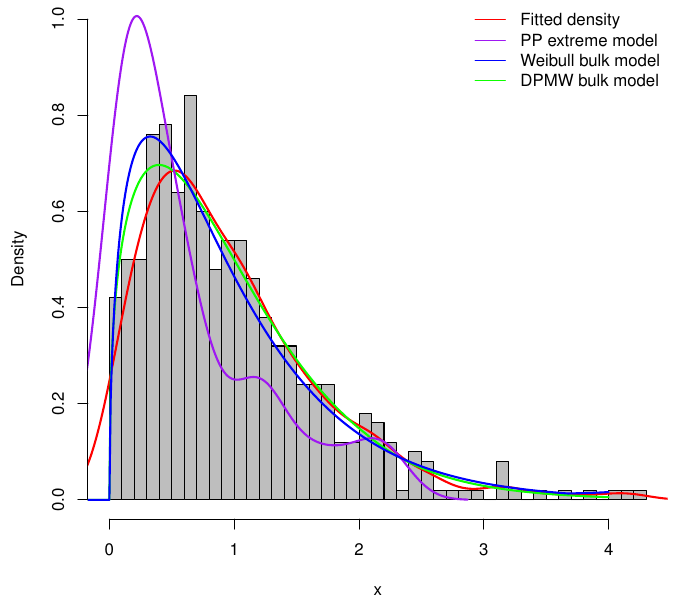
Figure 7. The posterior density plot for three models (the DPMW-PPR model, the PP extreme value model and the WMPP extreme model) with n = 500. The red line shows the true density function, the green line, the blue line and the purple line are the posterior density function of the DPMW-PPR model, the WMPP extreme model and the PP extreme value model, respectively.